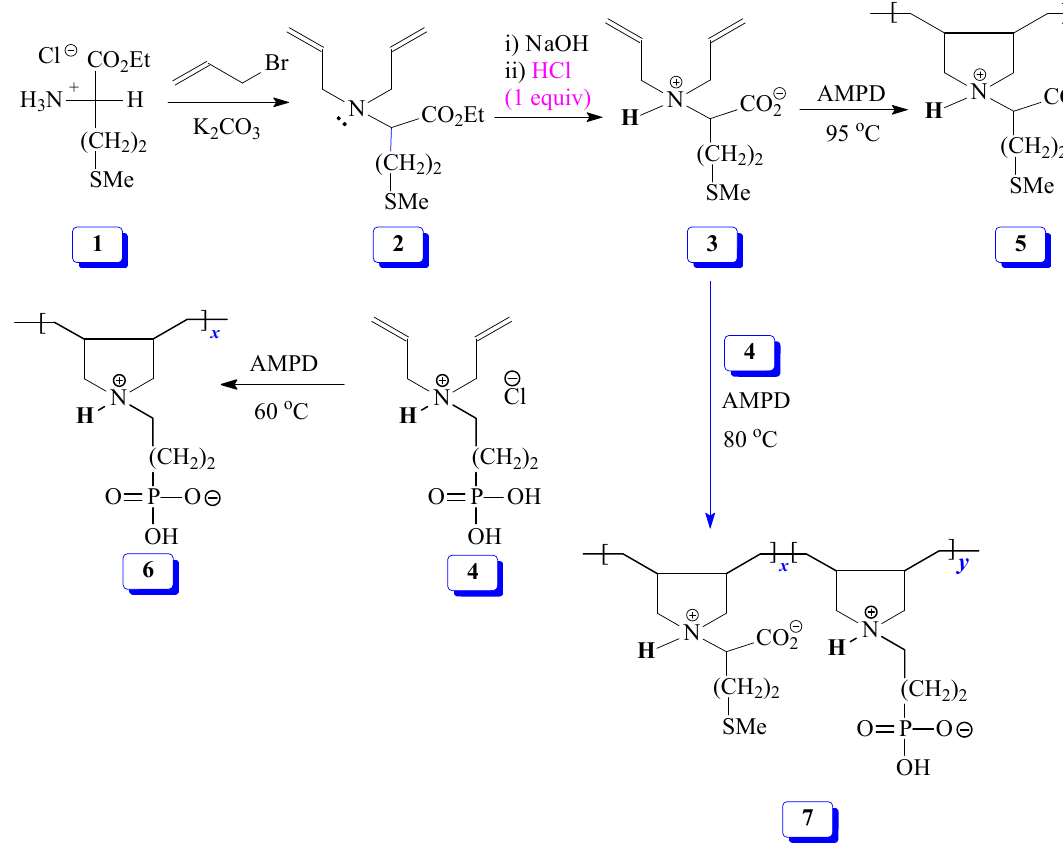
Scheme 1. The synthesis of monomers and